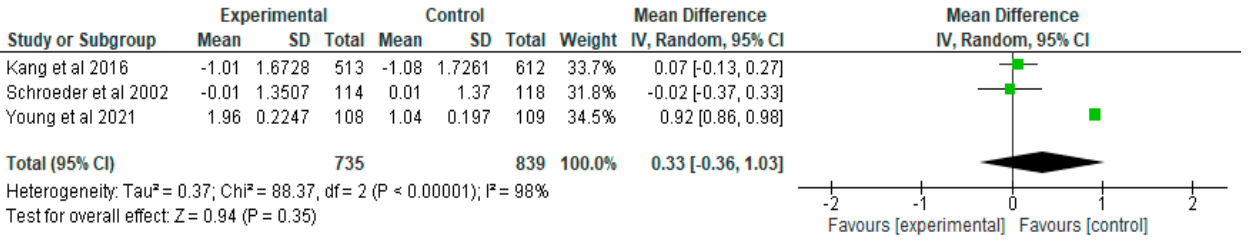
Figure 3. Assessment of the quality of articles (percentages) included in the meta-analysis [28–31].